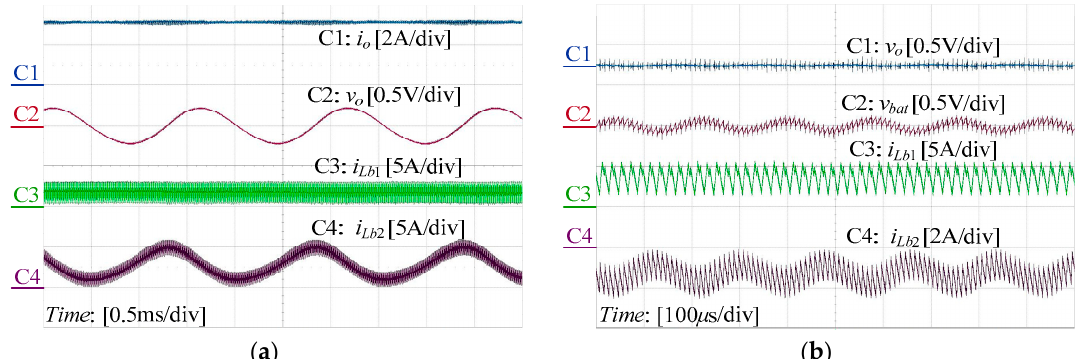
Figure 11. Experiment waveforms in operating mode M 1 and M 3 : ( a ) M 1 with I pvref = 0.3 A, V ocbat = 38 V, V pv = 26 V, I pv_ref = 0.3 A, I o = 3.3 A and τ i 1 = 0.8 ms; ( b ) M 3 with V pv = 24.5 V, I pvref = 2 A, I o = 1 A, τ i 3 = 4.7 μ s, V p = 0 V.